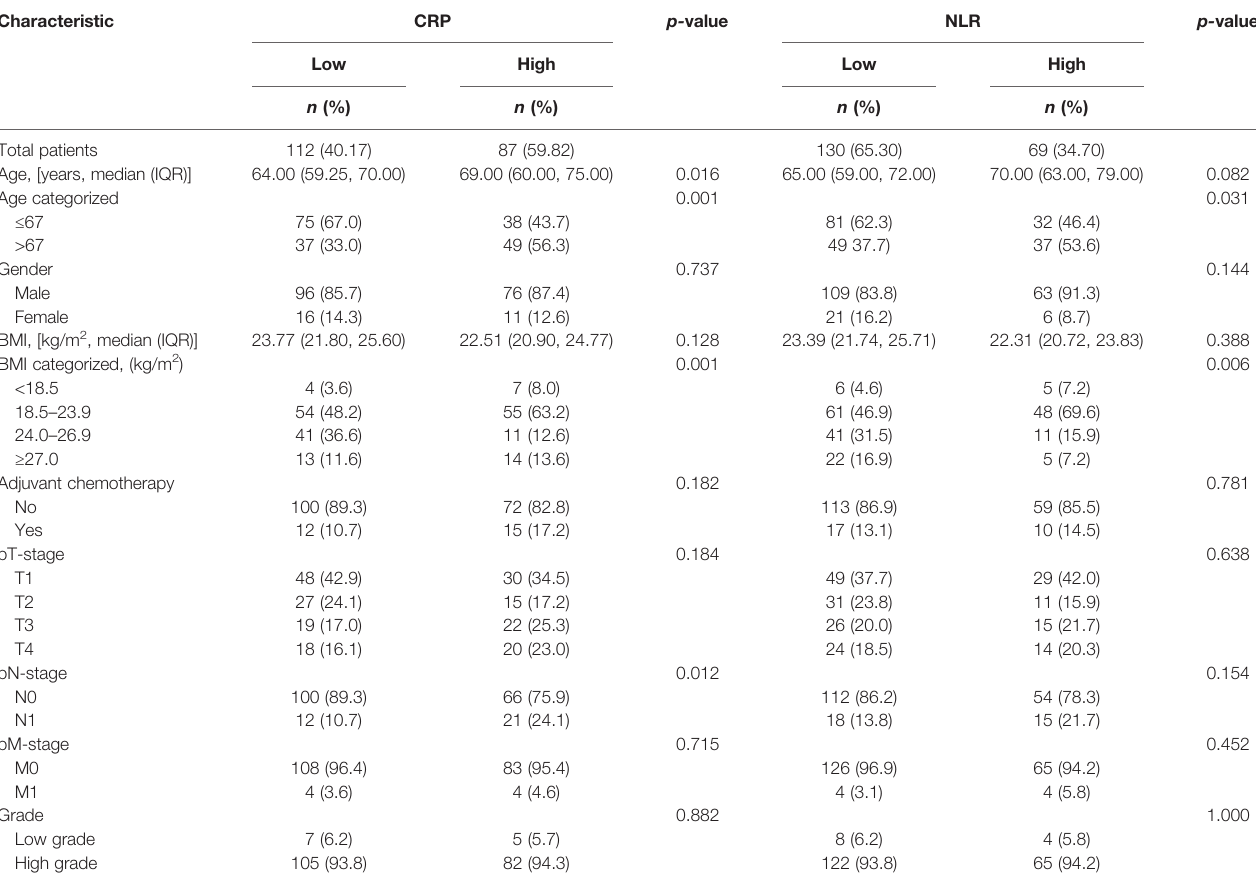
TABLE 2 | Baseline characteristics according to the subgroups classi fi ed by CRP and NLR. Characteristic